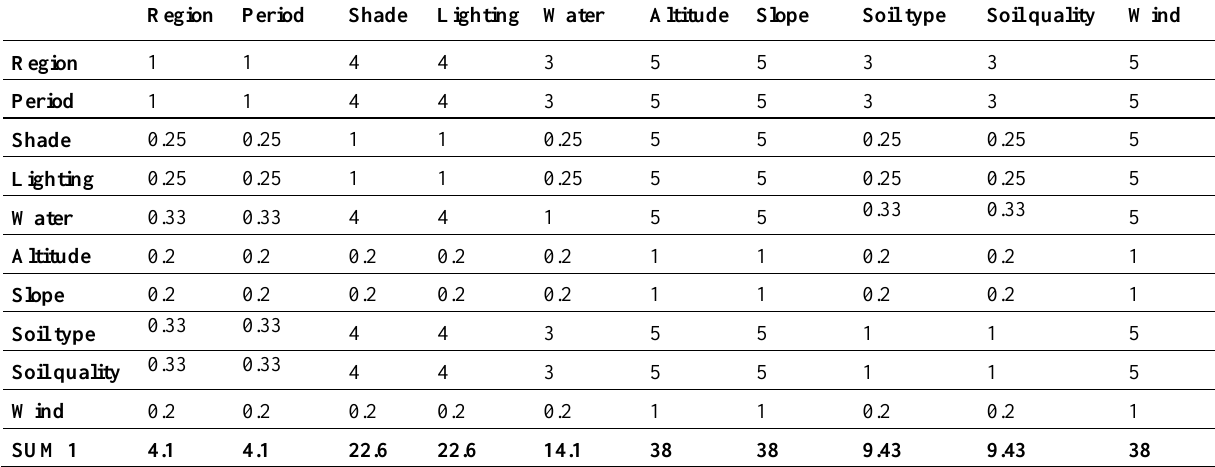
Table 2. Binary comparison matrix (Matrix 1)